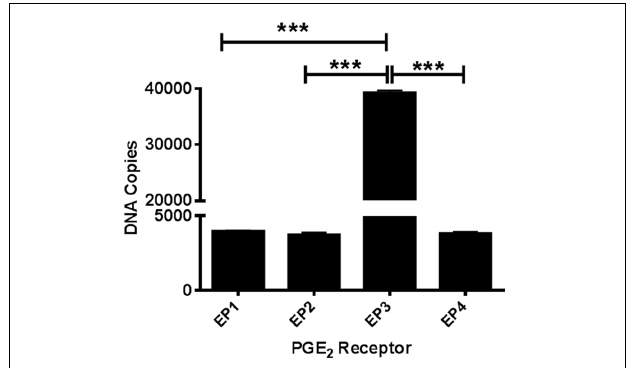
FIGURE 1 | PGE 2 EP1-4 receptors are expressed in cultured cortical neurons. Absolute qRT-PCR was performed using mouse-specific TaqMan assays to measure basal expression of EP1-4 receptors in postnatal neuronal cultures. The expression of the receptors EP1 through EP4 mRNA is presented as estimated DNA copies using linearized plasmid standards for each PGE 2 receptor. Data represents mean ± SEM of triplicate measures from four neuronal cultures. Statistical analysis was carried out using One-Way ANOVA, with Bonferroni’s multiple comparison tests. ∗∗∗ p < 0 . 001.